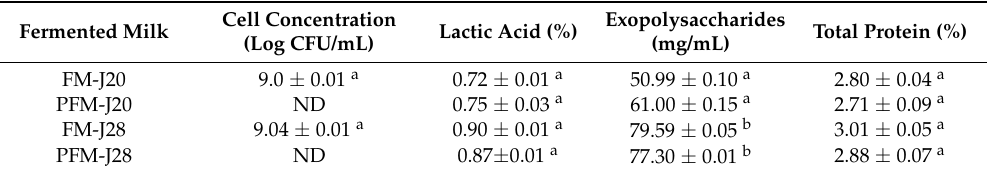
Table 1. Cell concentrations, total protein in fermented milk and metabolites derived from the fermentation